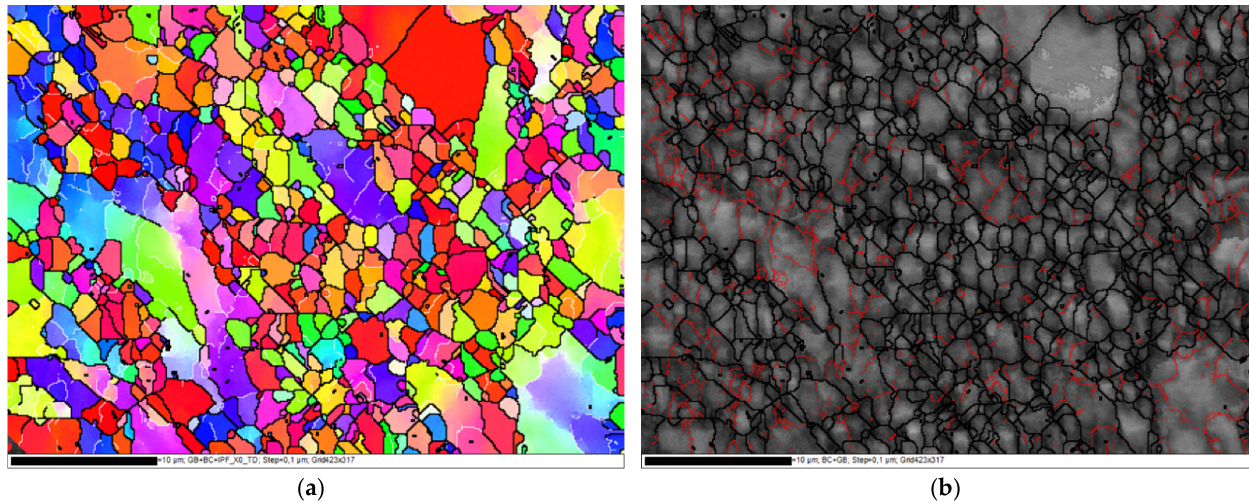
Figure 8. IPF coloring maps relative to ND and their corresponding BC map with high angle boundaries >15° in black lines and low angle boundaries 3–15° in red lines for the ZK30 billet processed through 4-Bc at higher magnification. ( a ) IPF coloring map ( b ) BC map.